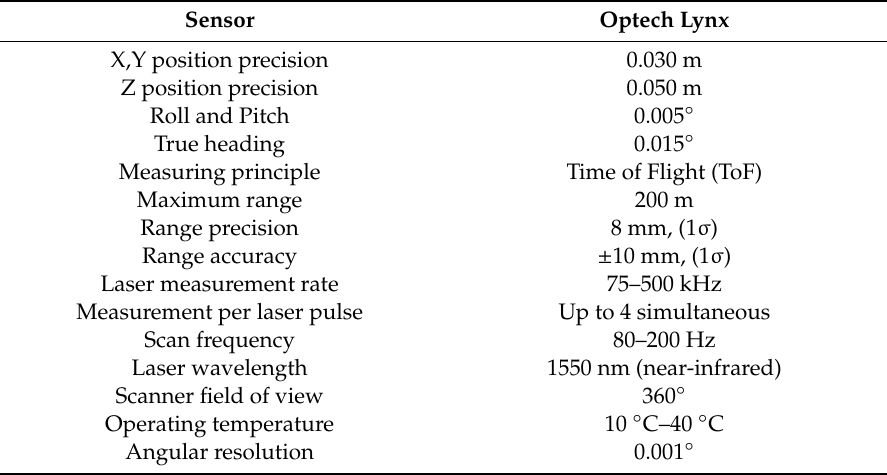
Table 3. Technical characteristics of the mobile mapping system (MMS) Optech